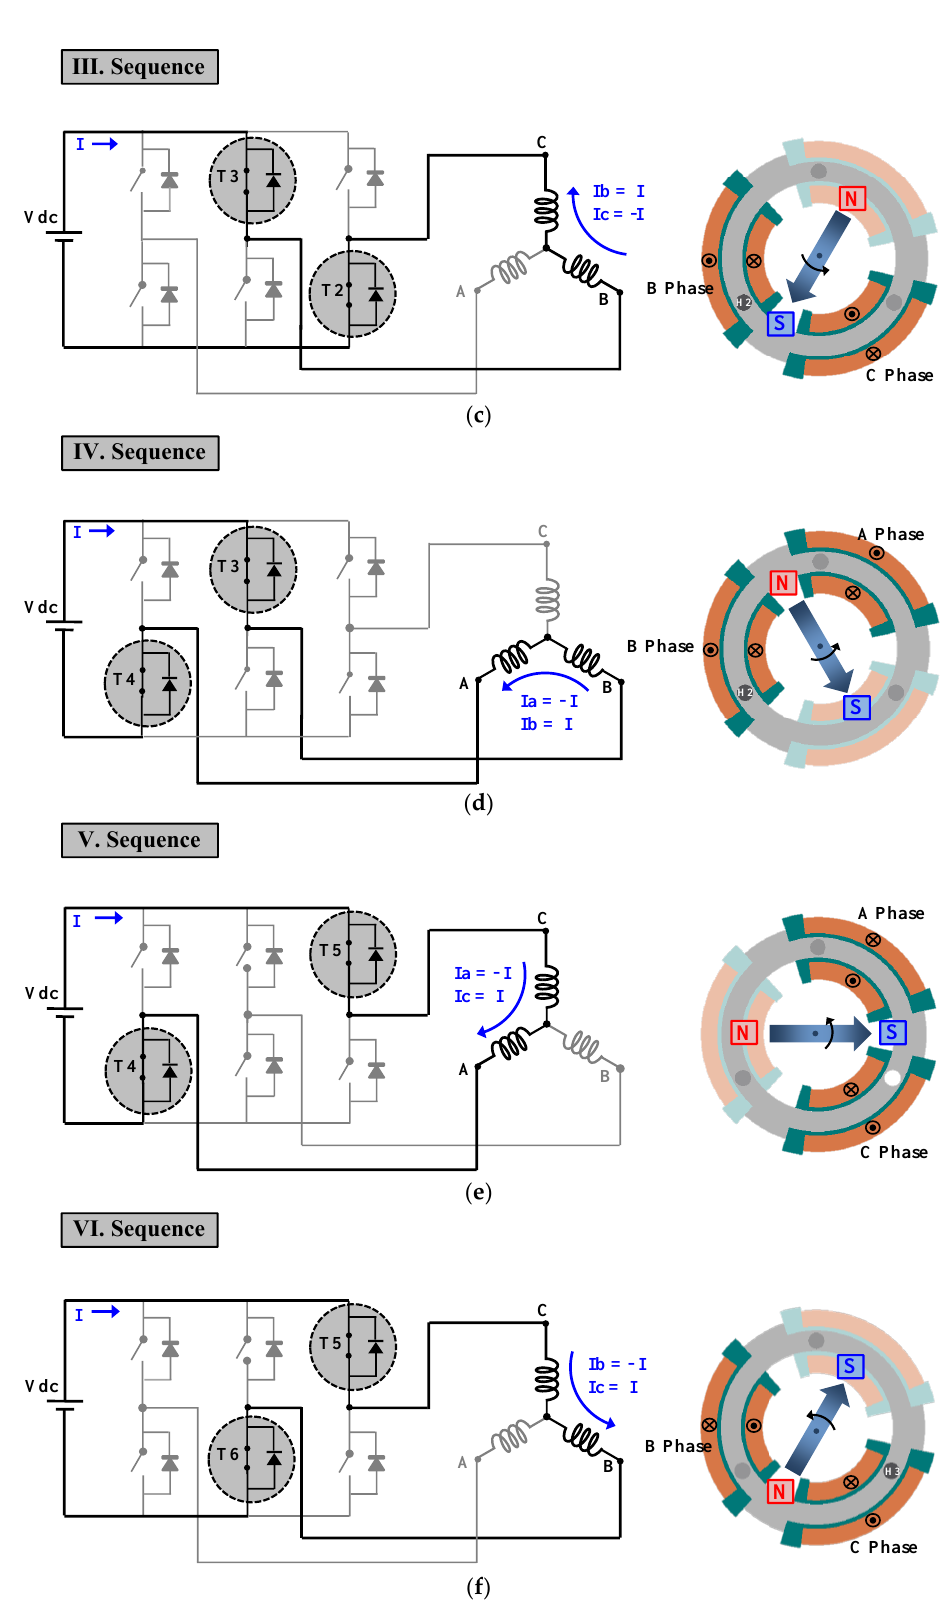
Figure 4. Driving process of three-phase 2-pole 3-coil bunch TSLM: ( a ) Sequence I, ( b ) Sequence II, ( c ) Sequence III, ( d ) Sequence IV, ( e ) Sequence V, and ( f ) Sequence VI.